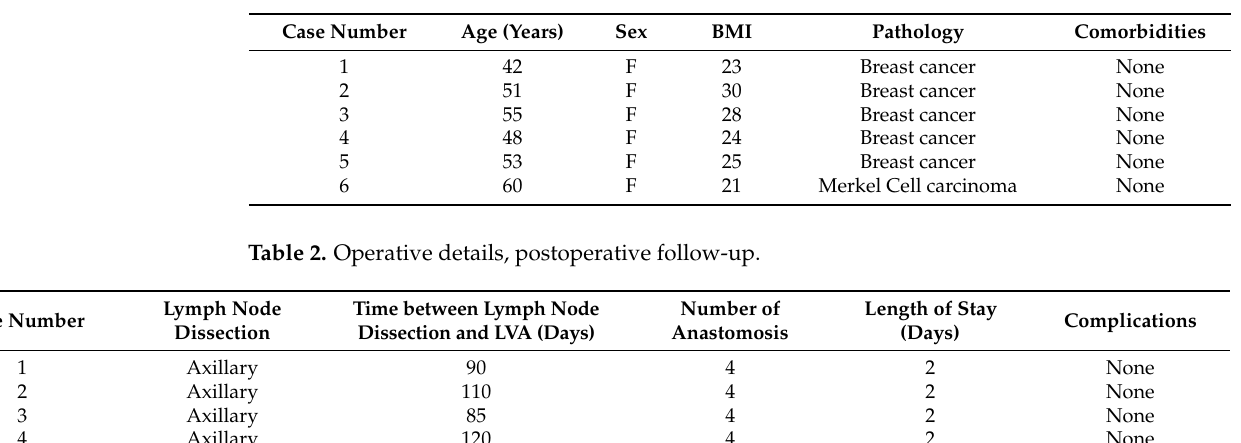
Table 1. Patients characteristics.